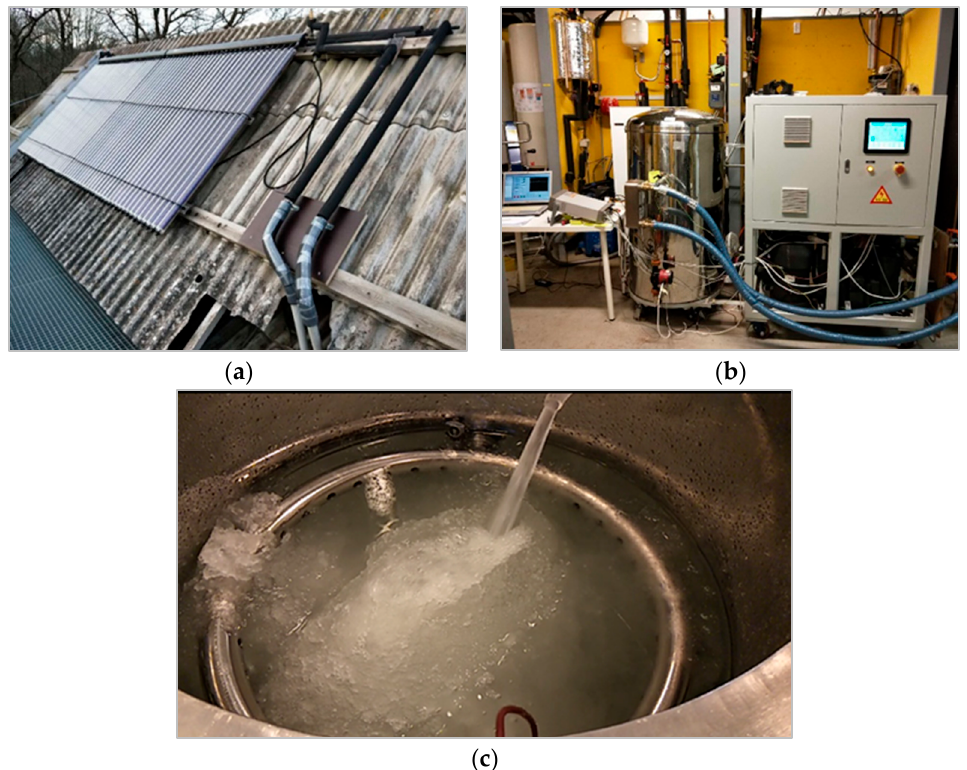
Figure 3. ( a ) Vacuum solar collector used in the experiment; ( b ) the ISHP installed in the solar lab; ( c ) the ice slurry in the heat storage tank.